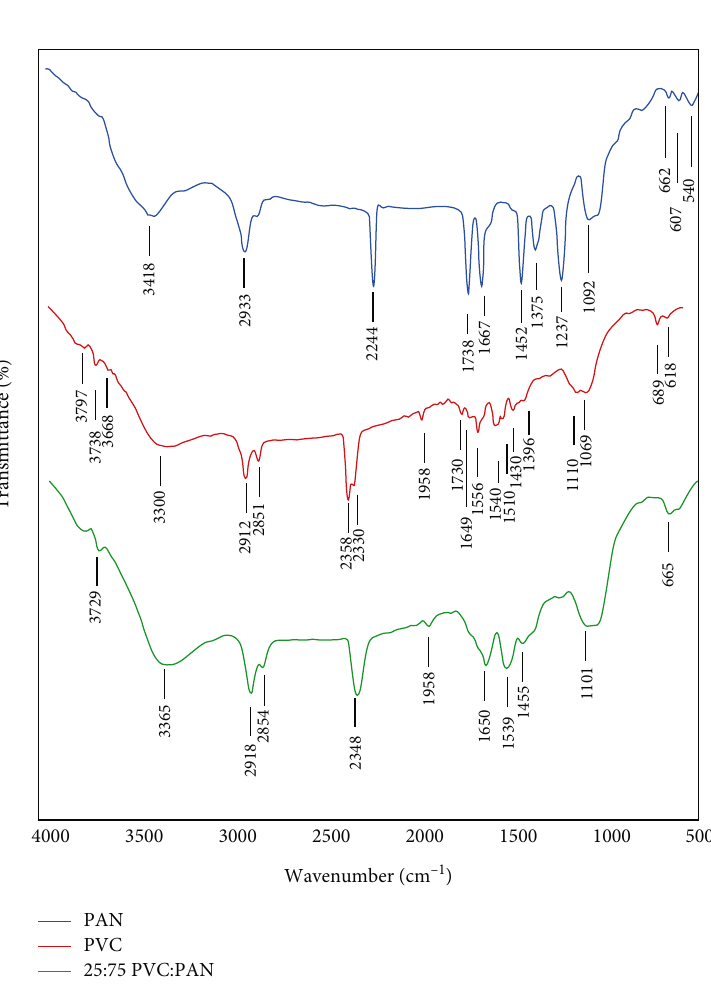
Figure 5: FT-R-IR spectra for pure PAN, pure PVC, and 25 :75 PVC: PAN nano fi bers.